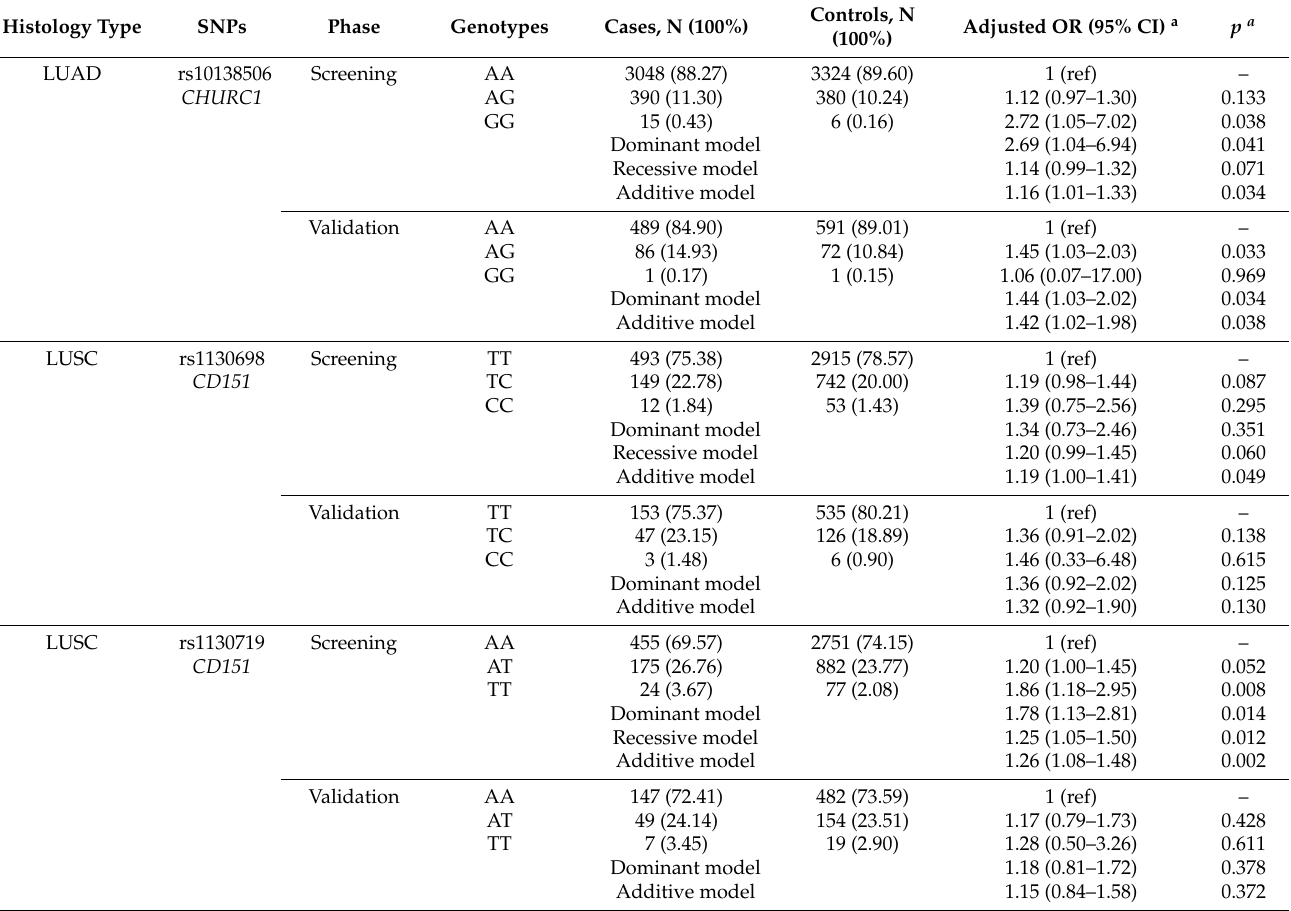
Table 4. Specific information of three candidate apaQTLs in the screening and validation